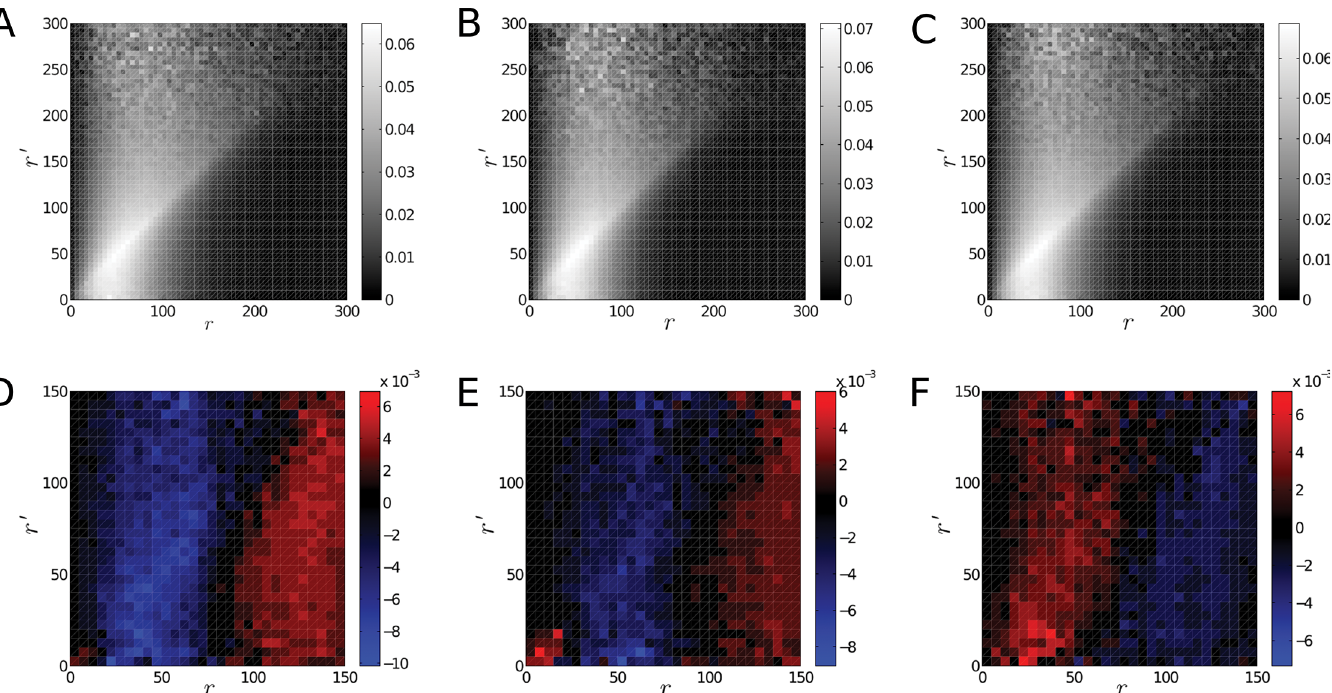
Fig 5. Conditional Probability Distribution of the Edge Lengths. Panel A. The panel shows the conditional probability distribution p ( r | r 0 ) of the edge lengths for the H2B markers before irradiation. The relatively prominent diagonal indicates locally a varying density. Panel B. The panel shows the conditional probability for the H2B markers 30 minutes after irradiation. Panel C. The panel shows the conditional probability for the H2B markers 48 h after irradiation. Panel D. The panel shows the difference of the conditional probabilities p ( r | r 0 ) measured for structures recorded before irradiation and for structures registered 30 min after irradiation. Shades towards red indicate values which are larger in the samples before irradiation, while values towards the shades of blue indicate probabilities which are larger in images registered 30 min after irradiation. The plot indicates slightly increased values along the diagonal after irradiation. This might mean a slightly increased clustering of the points. Panel E. The panel shows the differences of the conditional probability before irradiation and 48 h after irradiation. Entries in shades of red are larger in samples recorded before irradiation, while entries in shades of blue are larger in the samples recorded 48 h after irradiation. The trend is similar to that observed in panel D, however differences are less prominent. Panel F. The panel shows the differences if the conditional probability measured 30 min and 48 h after irradiation respectively. The red shades indicate larger probabilities in samples recorded 30 min after irradiation while blue shades indicate larger probabilities in samples registered 48 h after irradiation. Here a reversed trend compared to panel D was